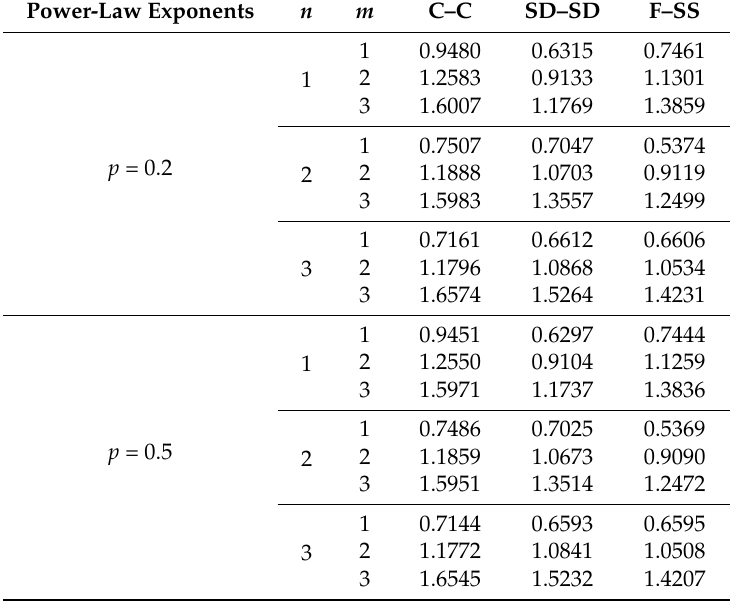
Table 6. Frequency parameters Ω for stepped FGM I ( a = 1; b = 0.5; c = 2; p ) shell with different power- law exponents.